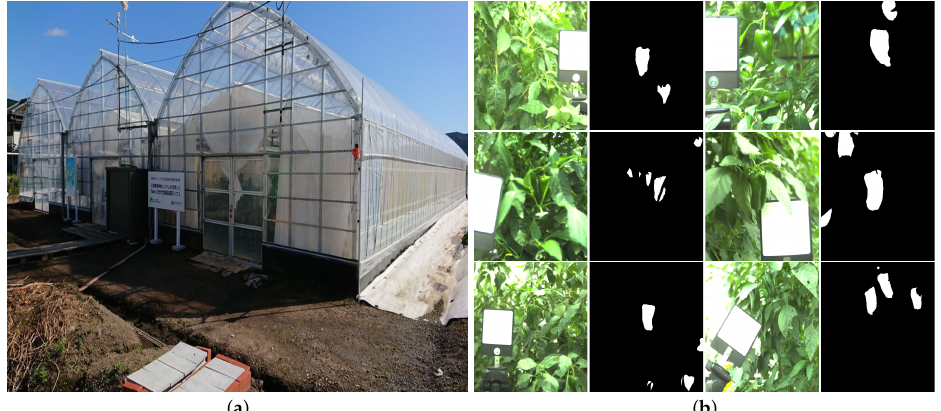
Figure 2. A photograph of the next-generation green house in Kochi University of Technology (KUT), and a sample sRGB image and the ground truth. ( a ) The next-generation green house in KUT. ( b ) Sample sRGB image and ground